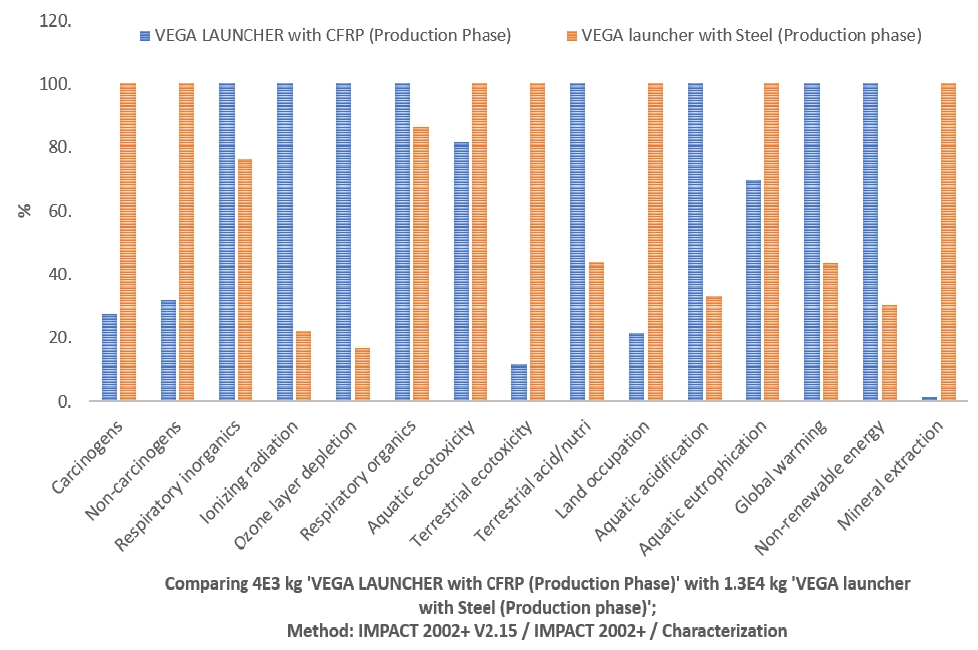
Figure 5. LCA results of comparison of production phase of stainless steel and CFRPs components into midpoint categories.